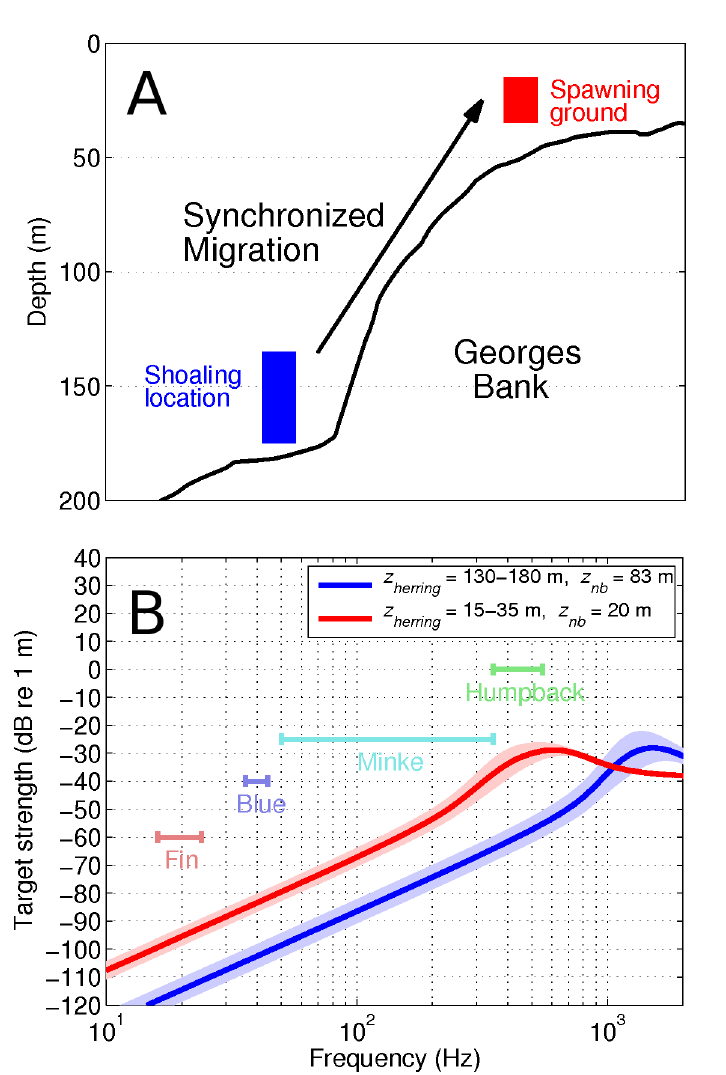
Figure 3. ( A ) Migration of herring shoals from depths greater than 100 m to less than 50 m in the Gulf of Maine; ( B ) Corresponding frequency dependence of resonance scattering of herring swimbladders for deep and shallow shoals. Blue and red solid lines represent the herring target strength when herring layer is at depths z of 130–180 m with a neutral buoyancy depth z nb of 83 m on the northern flank herring of Georges Bank and at depths z of 15–35 m with a neutral buoyancy depth z nb of 20 m on Georges herring Bank,